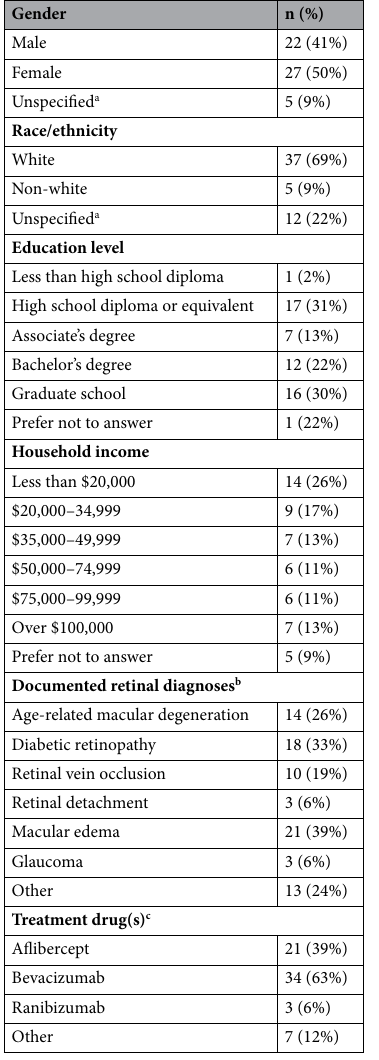
drugs over the course of their